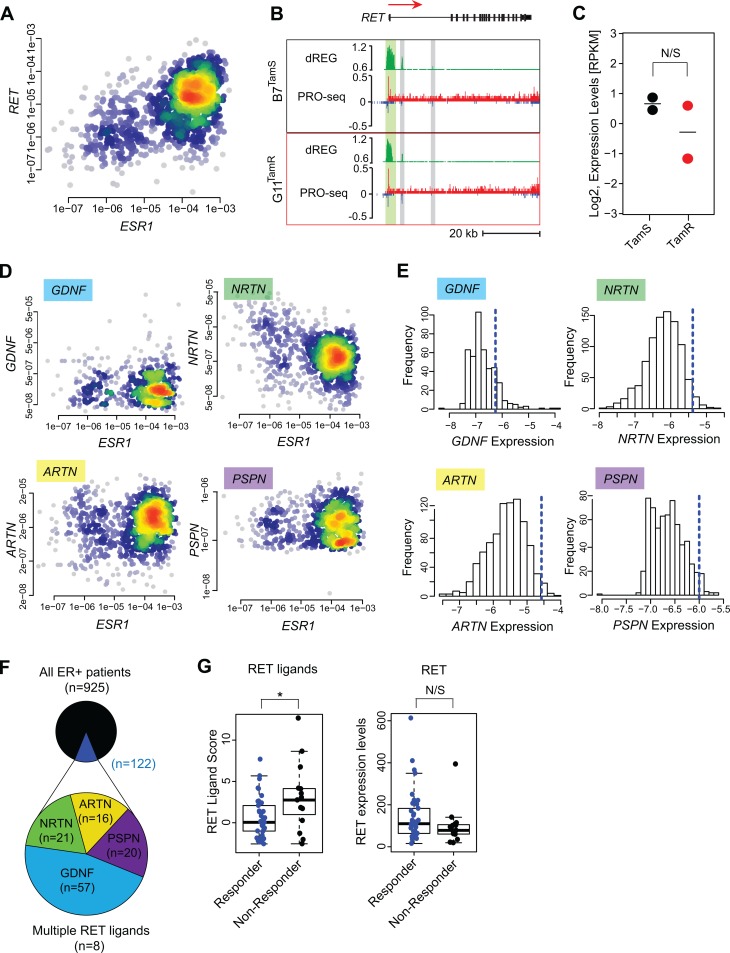
Expression of RET ligands contributes to endocrine resistance.(a) Density scatterplot showing RET and ESR1 expression in mRNA-seq data from 1,177 primary breast cancer models in the cancer genome atlas (TCGA). Spearman’s ρ = 0.51, p = 1.2e-60. (b) Transcription near the RET locus in B7TamS and G11TamR cells. PRO-seq densities on sense strand and anti-sense strand are shown in red and blue, respectively. dREG scores are shown in green. Enhancers and promoters are shown in grey and light green shading, respectively. Arrow indicates the directional movement of transcribed genes. (c) Dot plot shows RET transcription levels in TamS and TamR MCF-7 cells. (d) Density scatterplots show the expression of RET ligands (GDNF, NRTN, ARTN, and PSPN) versus ESR1 based on mRNA-seq data from 1,177 primary breast cancers. (e) RET ligand expression distribution in ER+ breast cancers. The dotted blue line represents 2.5 times the range between the 25th and 50th percentile. (f) Fraction of ER+ breast cancers (n = 925) with at least one RET ligand exceeding the threshold shown in panel E (shown in dark blue, n = 122). Among the 4 RET ligands, GDNF was the most highly expressed (n = 60). (g) Boxplots show RET ligands score and RET expression levels in patients that respond or do not respond to aromatase inhibitor letrozole. * p = 0.016.